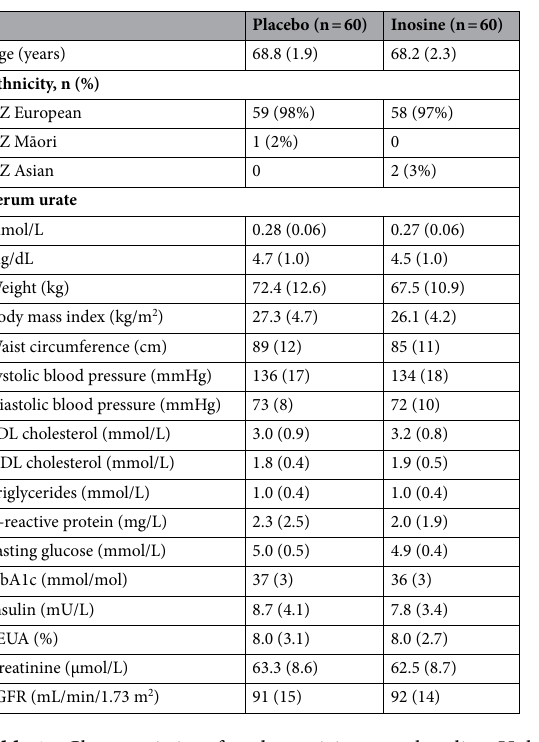
Table 1. Characteristics of study participants at baseline. Unless otherwise stated, data are presented as mean (SD). Baseline demographic values, weight, body mass index, serum creatinine, and serum urate have been reported previously 10 .